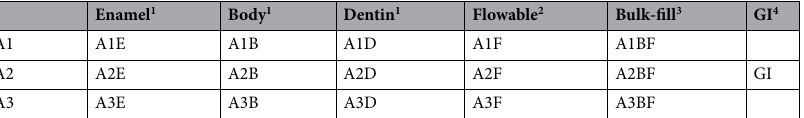
Table 1. The experimental groups in this study. Products: 1 Filtek™ Z350 XT; 3M ESPE, St. Paul, USA. 2